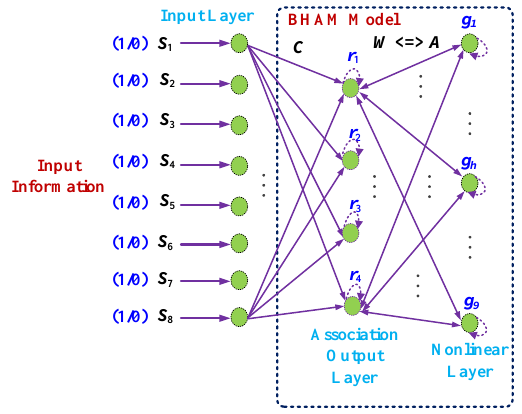
Figure 6. Proposed bidirectional hetero-associative memory network model.